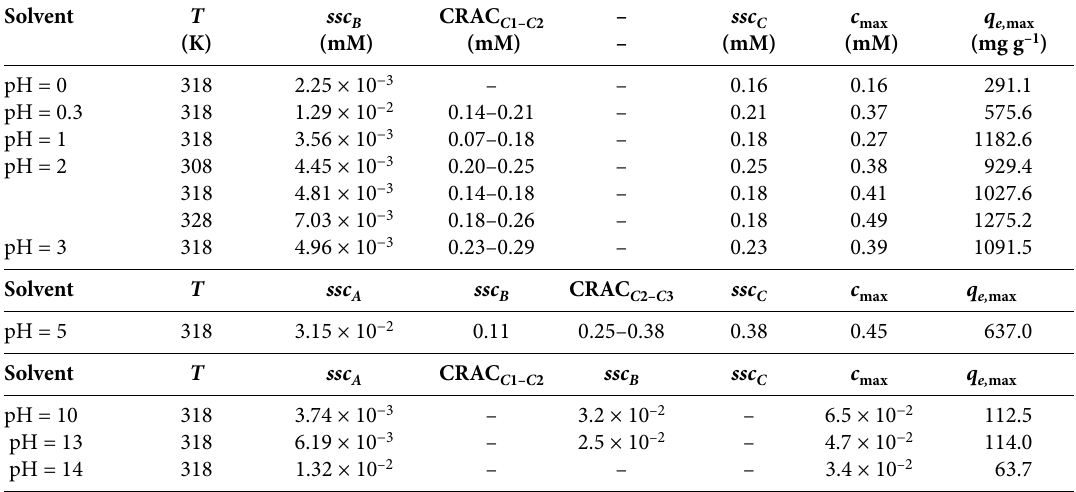
Table 3. CRACs for the adsorption of ARS on GO/PAMAM in water, alkaline and acidic solutions at 100 rpm and 308–328 K.